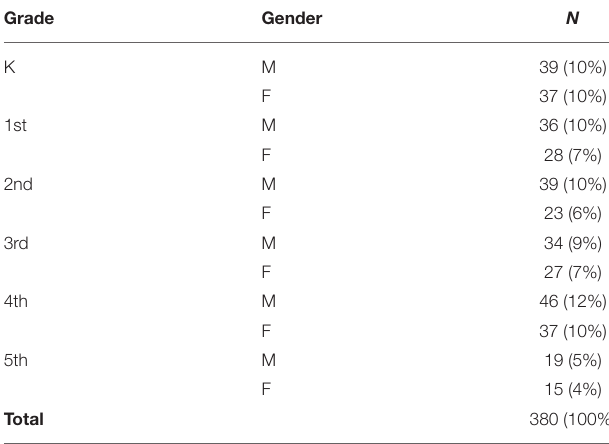
TABLE 1 | Participants by grade and